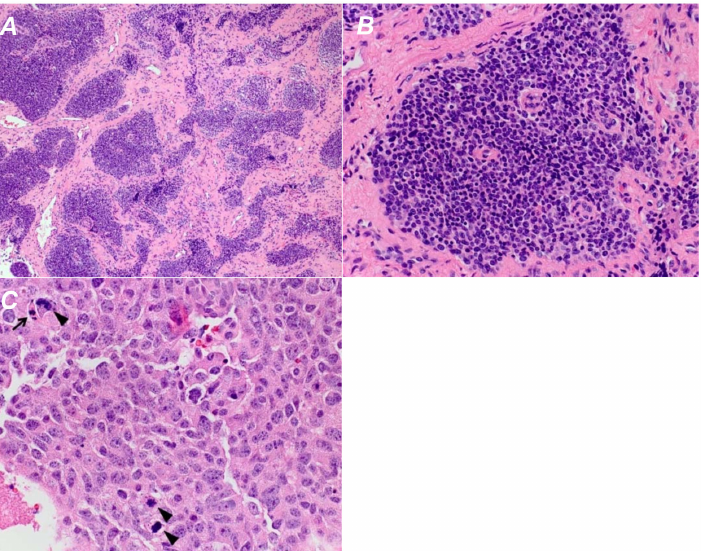
Figure 2. Low-power view of an olfactory neuroblastoma displaying a well-defined lobular growth pattern ( A ). On higher magnification, each lobule is composed of a uniform population of cells with minimal pleomorphism ( B ). No increased mitotic activity or evidence of necrosis is seen. These features are consistent with a Hyams grade 1 olfactory neuroblastoma. ( C ) A case of olfactory neuroblastoma with prominent pleomorphism and several mitotic figures (arrowheads). Scattered apoptotic cells are also identified (arrow). These features are those of Hyams grade